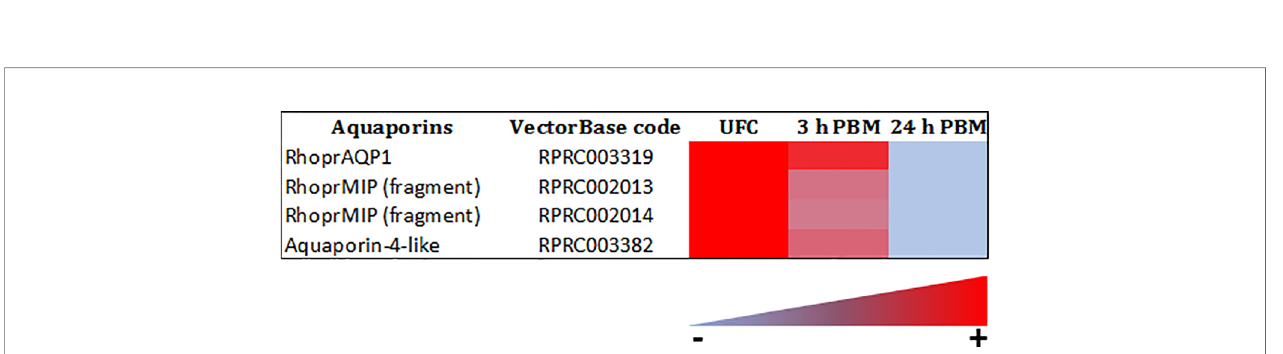
Frontiers in Endocrinology |